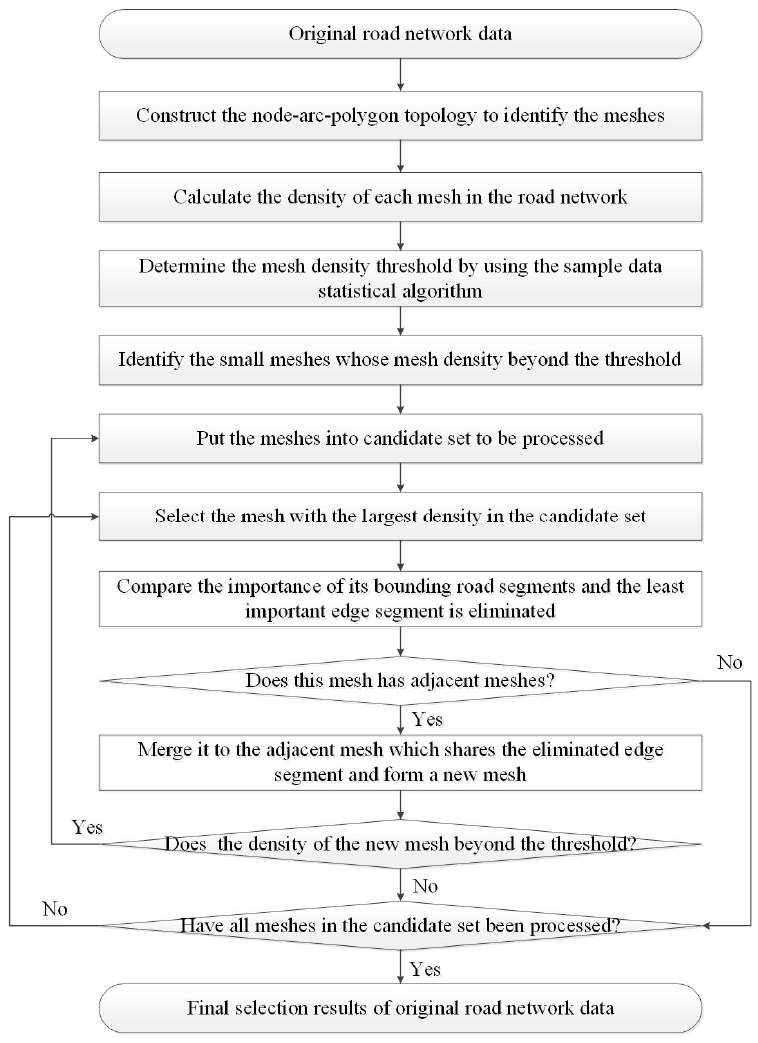
Figure 3. Flowchart of the traditional mesh-based approach.